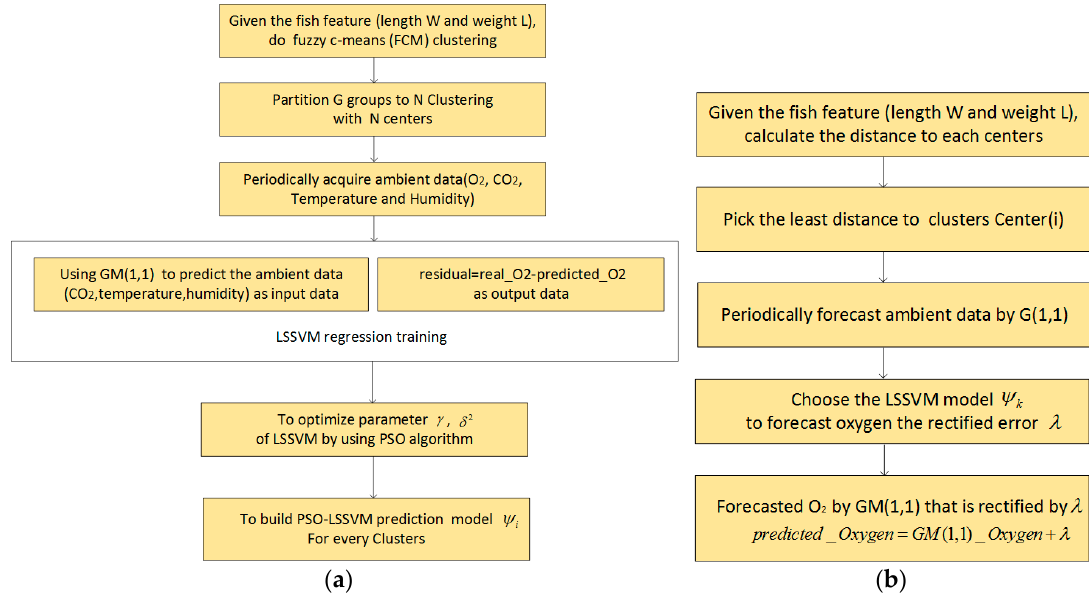
Figure 4. Modeling procedure of GM-PSO-LSSVM forecasting with error rectification.